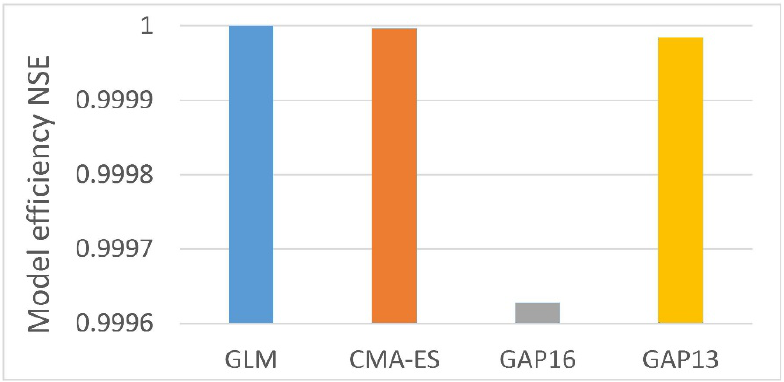
Figure 3. Presentation of NSE results for the calibration period.